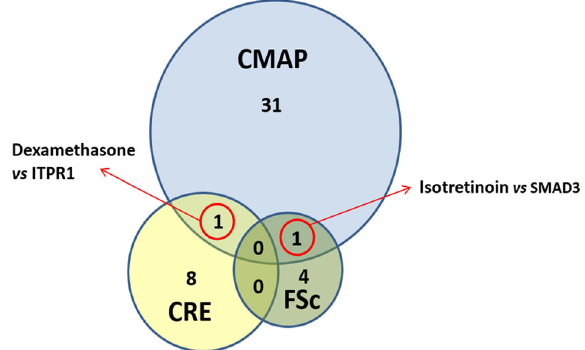
Fig. 2 Venn diagram showing the overlap of the validated drug- gene interactions identi fi ed by the three methods. Thirty four of 685 CMAP hits tested, 9 of 85 CREKB hits and 5 of 55 hits identi fi ed in the fi broblast cell-based screen validated by qRT-PCR measurement of target mRNA in single drug dosing (2 uM) of fi broblasts for 8 h. (Table 2)